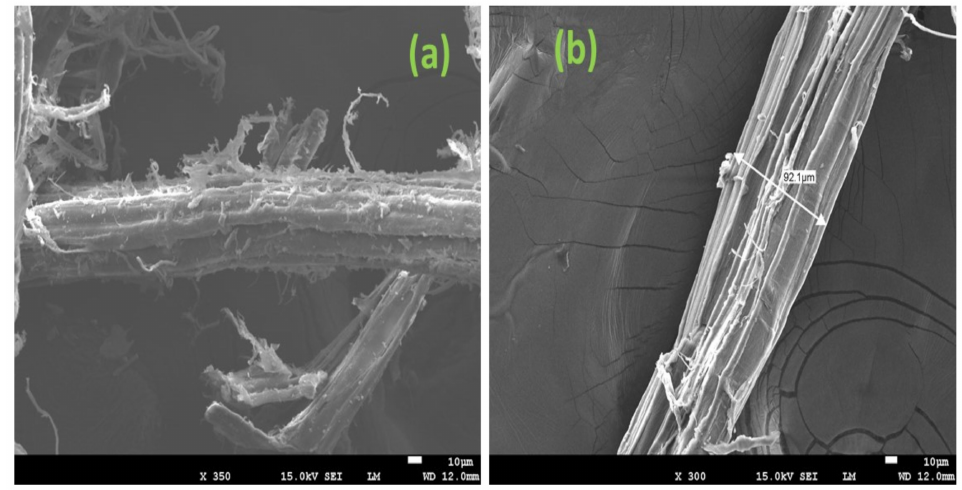
Figure 8. SEM images showing the influence of treatment on banana fibre morphology: untreated ( a ) and treated ( b ) banana fibres.